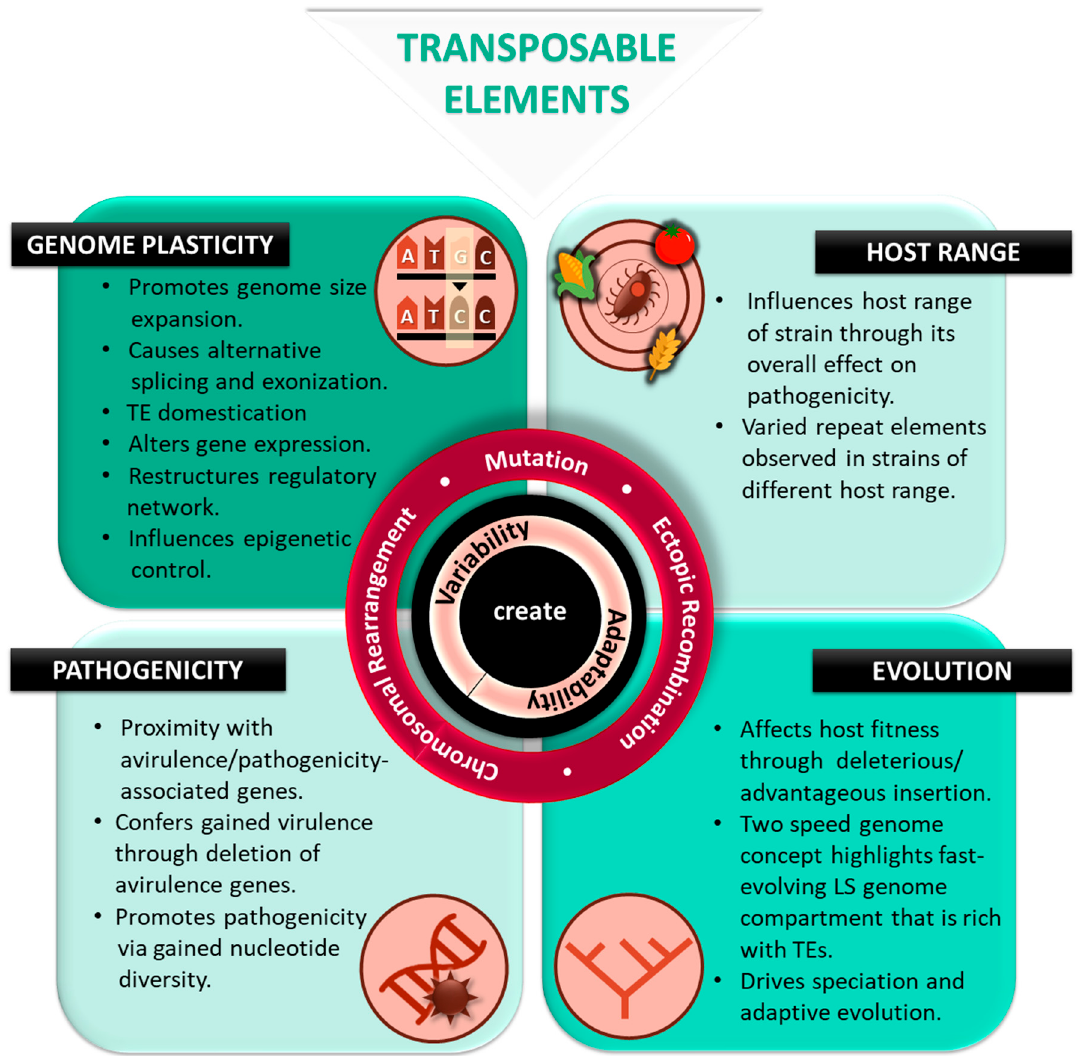
Figure 2. The role of transposable elements in affecting genome plasticity, influencing host range and pathogenicity, and shaping evolution of phytopathogens. Transposable elements generate genetic variability that can contribute to host adaptation to its surroundings. The mechanisms involved include TE-mediated mutation, ectopic recombination and chromosomal rearrangement. Collectively, TEs can influence agriculturally relevant traits exemplified by observations made in rice pathogens and other fungal phytopathogens. (Source: Credit Ilakiya Kumar).